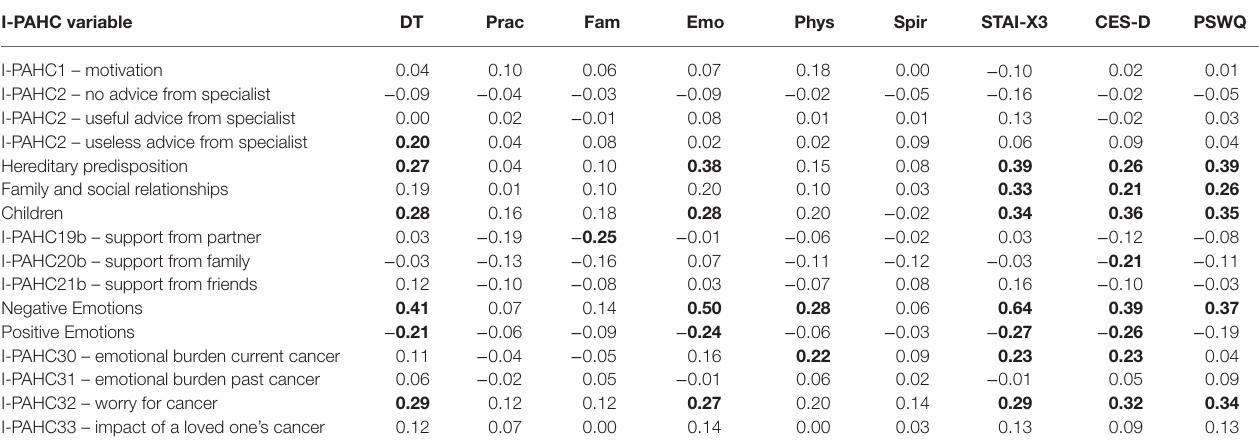
TABLE 2 | Correlations of I-PACH scores with the other psychological measures. I-PAHC variable